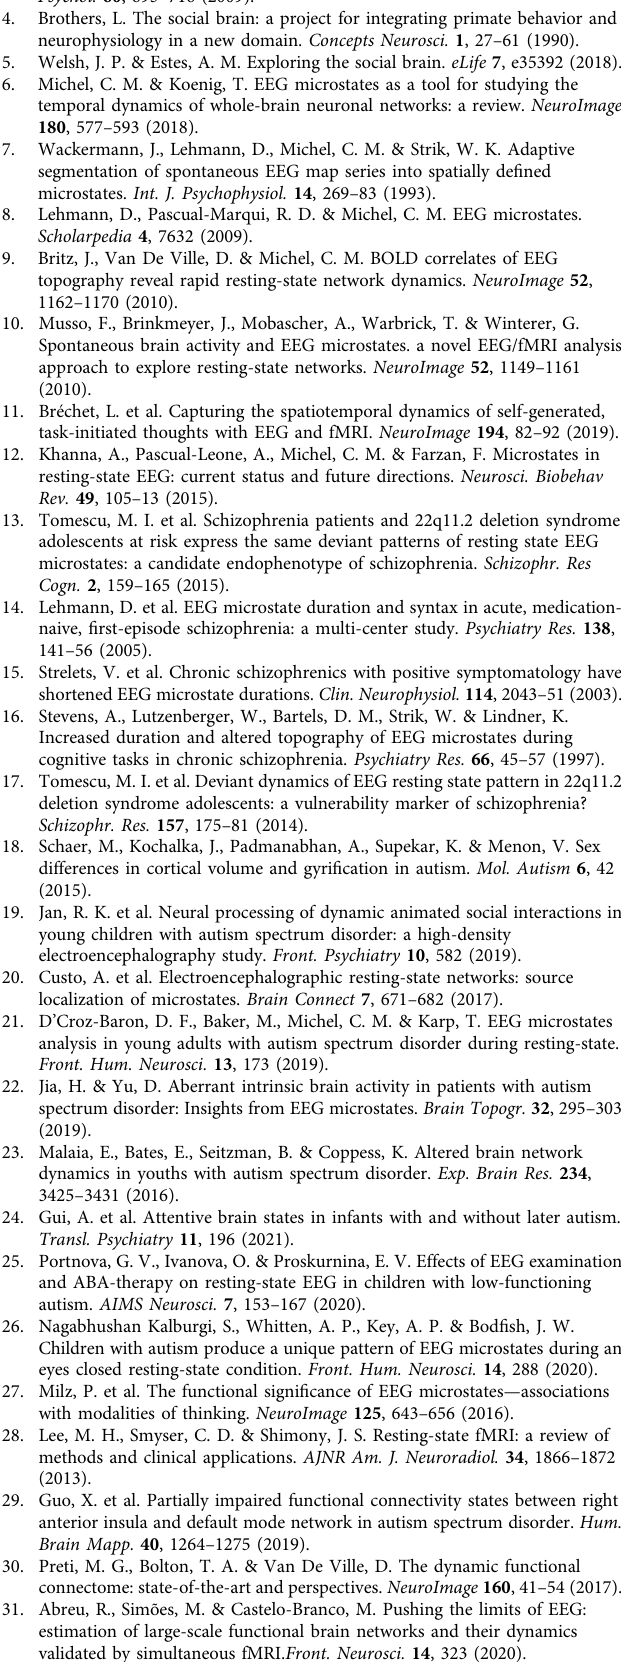
Fig. 7 Microstate analysis pipeline. a Standard preprocessing of all the acquired high-density electroencephalography (EEG) recordings (110 channels). b A 2 s cleaned EEG and its corresponding global fi eld power (GFP). Periods of quasi-stable map topographies (on top) are superimposed on the cleaned EEG and marked in different colors. c For each individual recording, peaks of GFP were determined (red vertical lines) and their speci fi c potential maps were selected and submitted to a k-means clustering procedure ( d ). The best k-means clustering solutions at the individual level were selected based on the meta-criterion. e The best solutions obtained for each subject in step ( d ) were submitted altogether to a second k-means group cluster analysis. The meta-criterion identi fi ed a best solution with 5 template topographies (microstate classes). f The template topographies obtained in ( e ) were fi tted back to the individual EEG recordings and each time point was labeled with the cluster map having the highest spatial correlation (winner-takes-all). The microstate sequence was used, for each subject, to extract the temporal parameters and